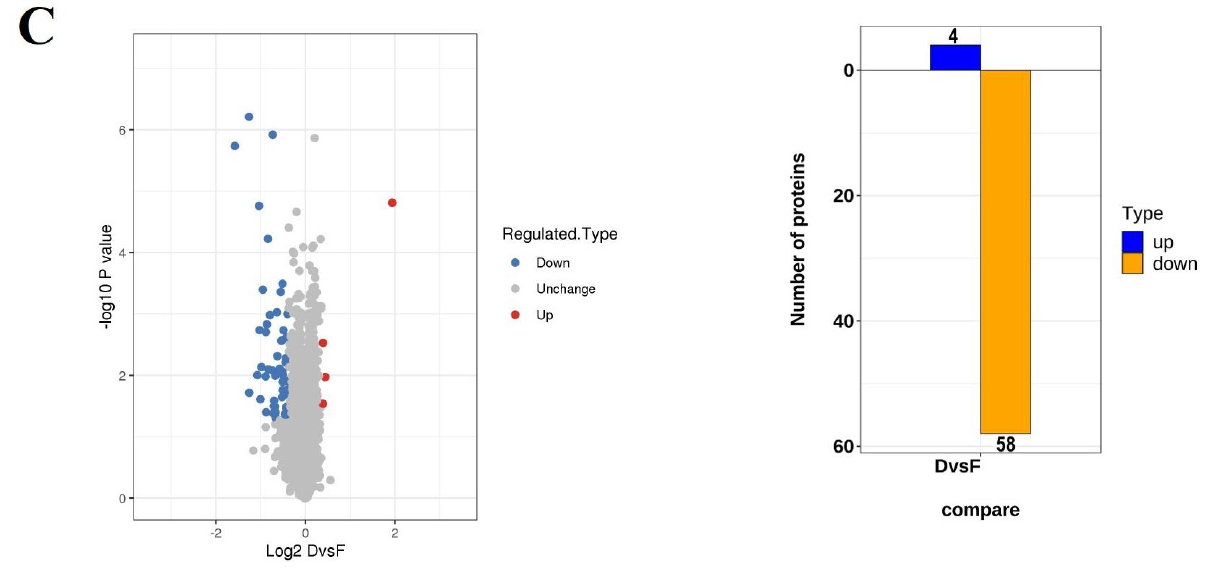
Figure 3. The numbers of DEPs in different comparisons. ( A ) The volcano and numbers of the up- and down-regulated proteins in L. monocytogenes 10403s vs. the control (D/B). ( B ) The volcano map and numbers of the up- and down-regulated proteins in L. monocytogenes M7 vs. the control (F/B). ( C ) The volcano map and numbers of the up- and down-regulated proteins in L. monocytogenes 10403s vs. L. monocytogenes M7 (D/F).